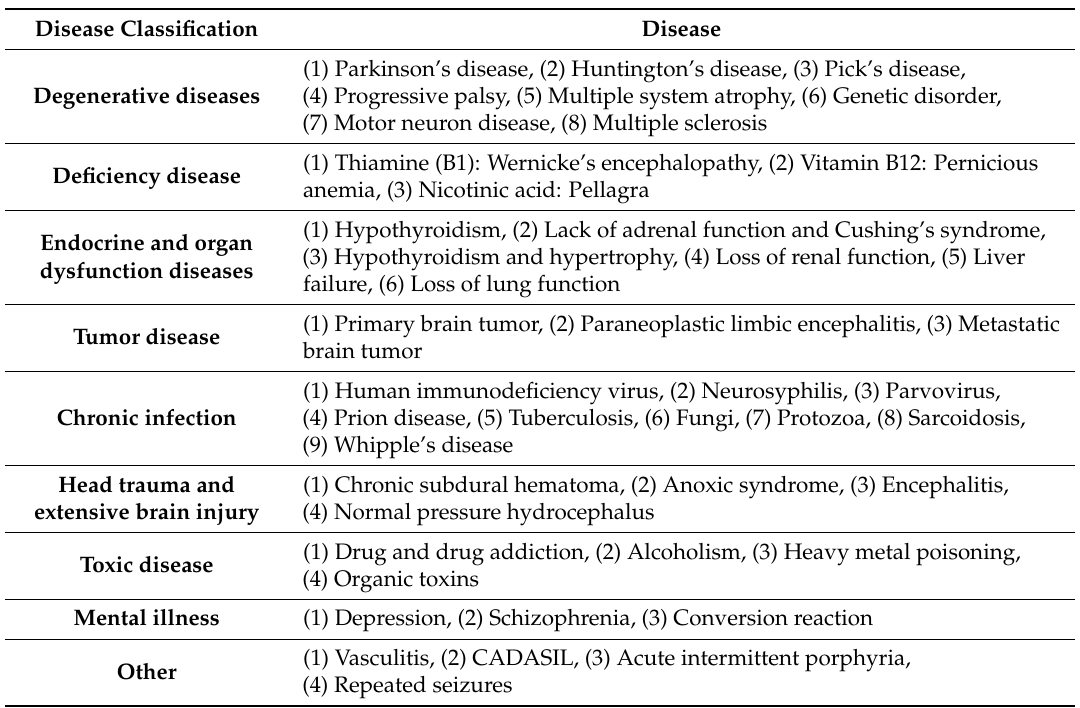
Table 5. Known dementia-related